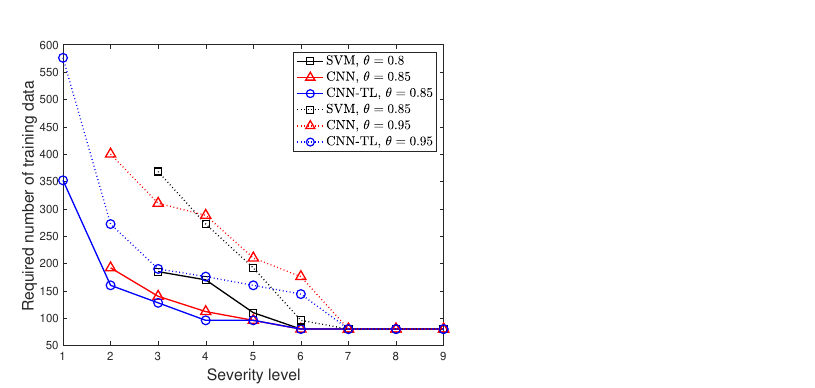
Figure 10. Required number of training samples of SVM, the CNN, and CNN–TL with different severity labels, l = 1, . . .